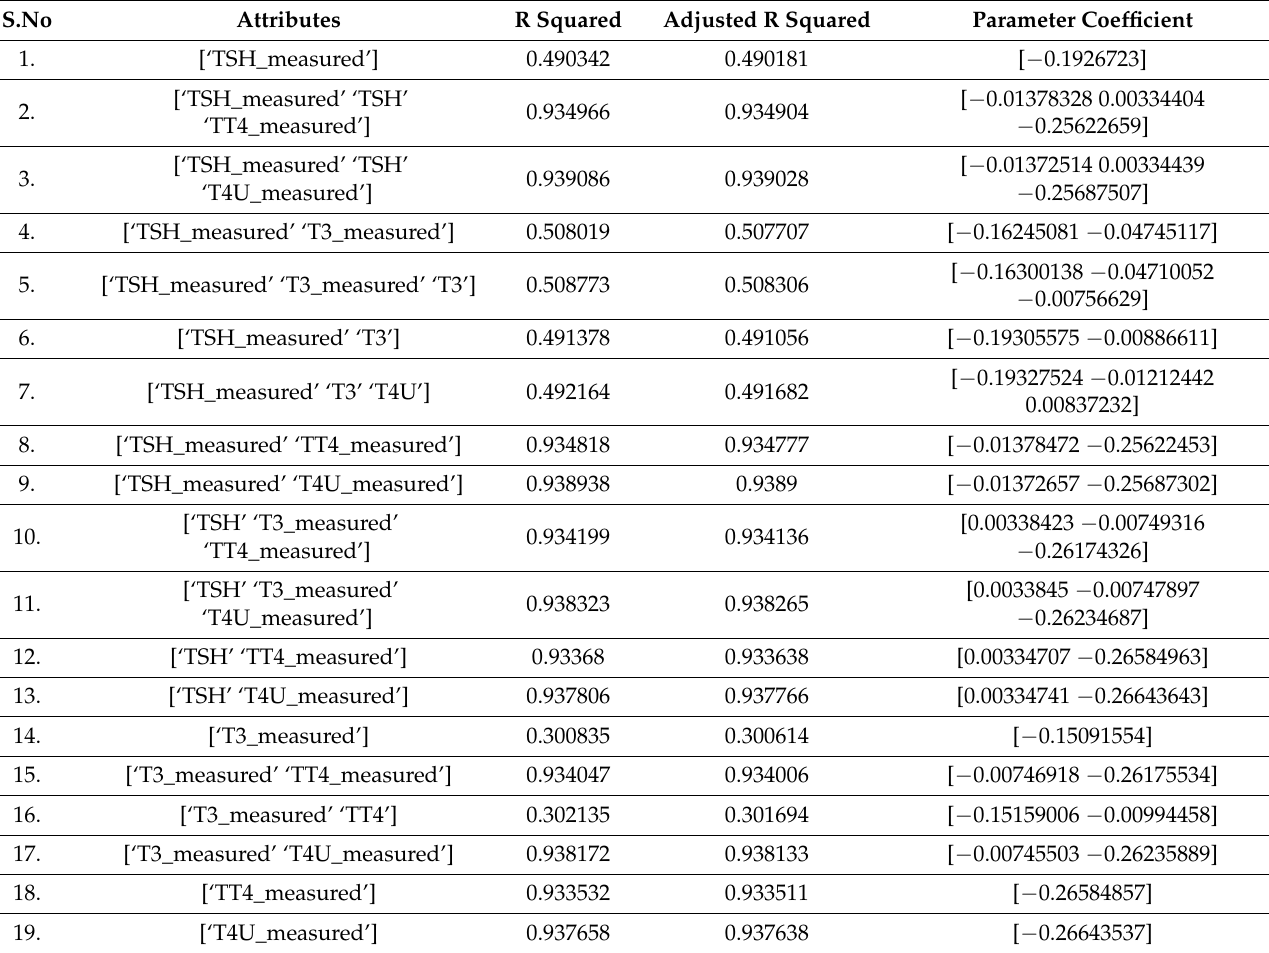
Table 25. OLS features of the significant subset attributes of the hypothyroidism dataset.